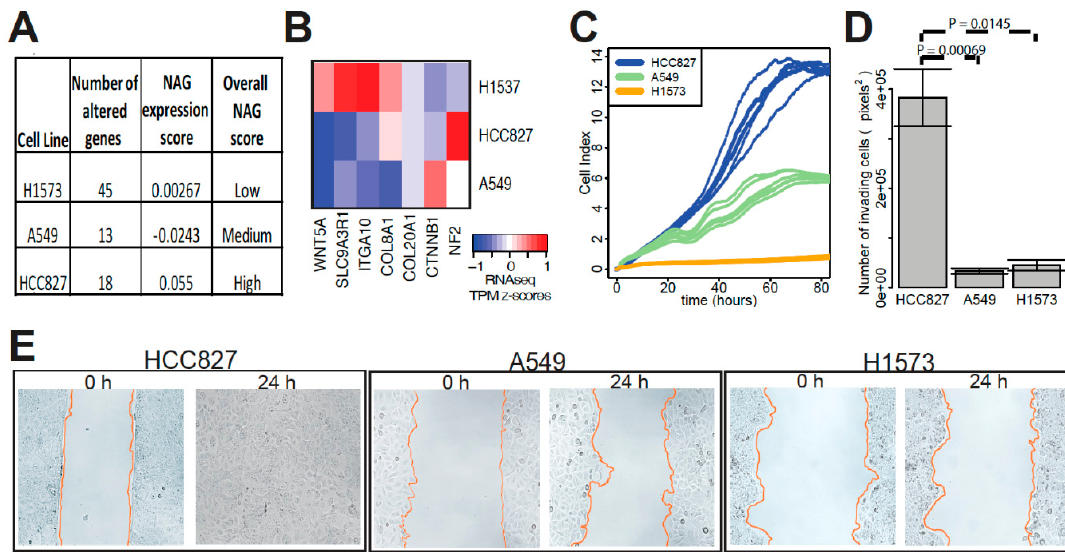
Figure 5. Functional impact of altered and differentially-expressed genes on cancer cells. ( A ) The number of genes (out of 865 genes) with somatic SNV or CNA was tallied for routinely-used lung cancer cell lines. Three lung cancer cell lines with differing overall NAG (based on quartiles) and different risk scores for NAG associated expression signature were compared to each other in functional assays. ( B ) A heatmap of RNA expression level scaled across cell lines for NAG genes commonly altered in TCGA is shown for the three lung cancer cell lines. ( C ) Proliferation of the three cultured cell lines was estimated by electrical impedance (cell index) over time. ( D ) Invasion of cells across trans-well membranes coated with Matrigel was counted. ( E ) Cell motility was measured by a time-lapse wound-healing assay. The rates of wound area travelled by cells were 15.42 µm/hr for HCC827, 2.64 µm/h for A549 and 1.98 µm/h for H1573.